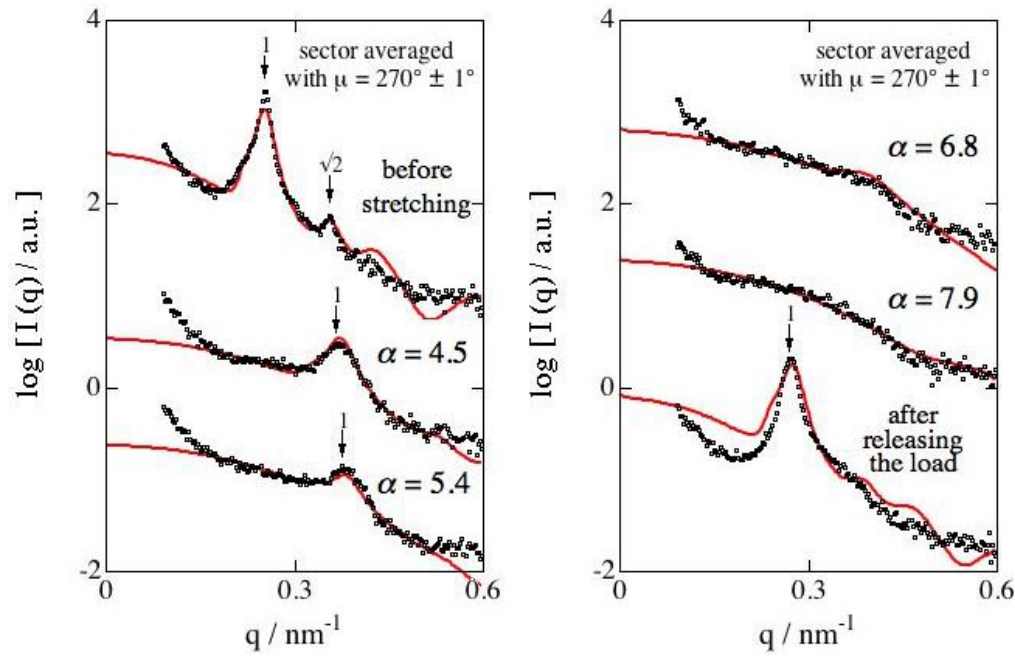
Figure 6. 1d-SAXS profiles perpendicular to the stretching direction converted from 2d-SAXS patterns shown in Figure 4 by conducting the sector averaging over the azimuthal angle range with  = 270° ± 1°. The solid curves are results of the calculated profiles based on the bcc model.